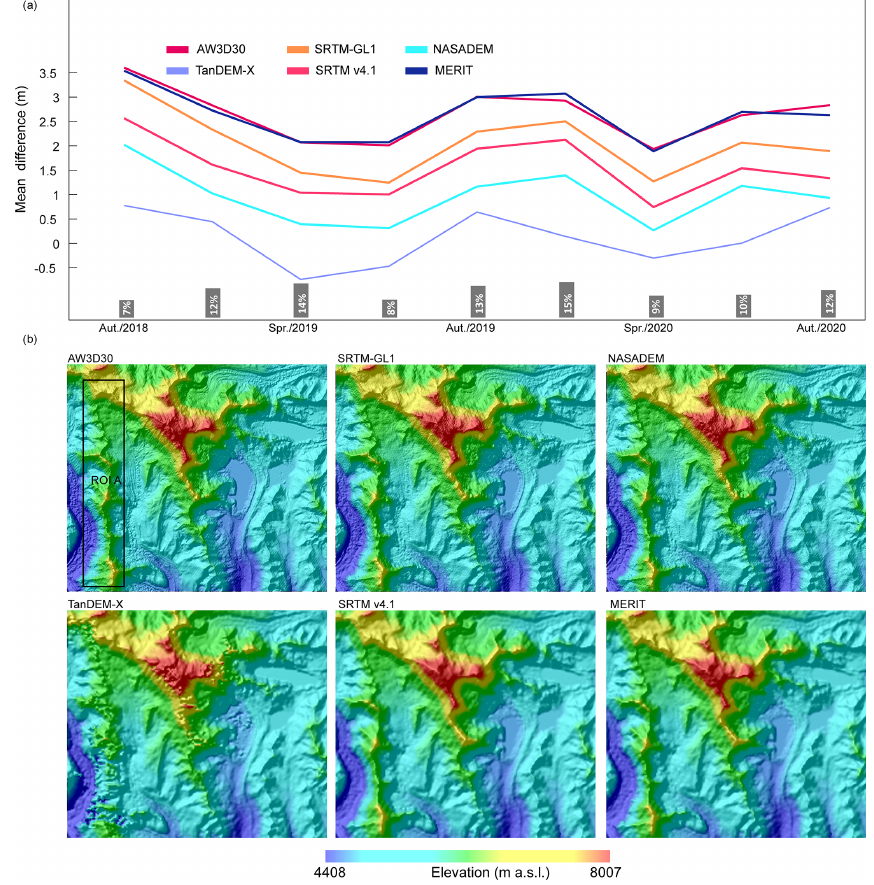
Figure 11. Influence on elevation differences between ICESat-2 and six DEMs from glacier elevation change and terrain factors. (a) Mean absolute difference between six DEMs and ICESat-2 in different seasons during 2018–2020. The spring, summer, autumn, and winter are defined as March–May, June–August, September–November, and December–February, respectively. The histogram at the bottom shows the percentage of the total number of points in each season. (b) Examples of elevation and shaded relief of six DEMs in the Shisha Pangma region. The rectangle denotes the area of interest.